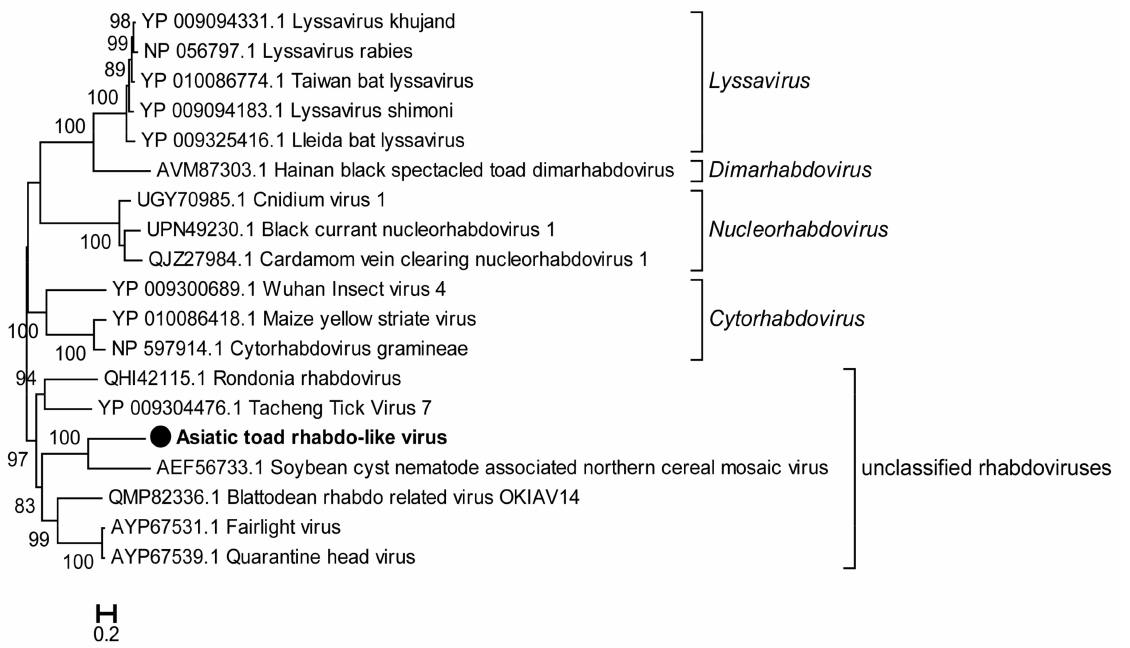
Figure 5. Phylogenetic analysis based on the amino acid sequence of the RdRp of AtRhabV compared with those of other rhabdoviruses. The tree was constructed using the Maximum Likelihood method in PhyML with 1000 bootstrap replicates. The novel strain identified in this study is marked with a black solid circle and indicated by bold text. Percent bootstrap support is indicated by the value at each node. Taxonomy information is reported on the right of each